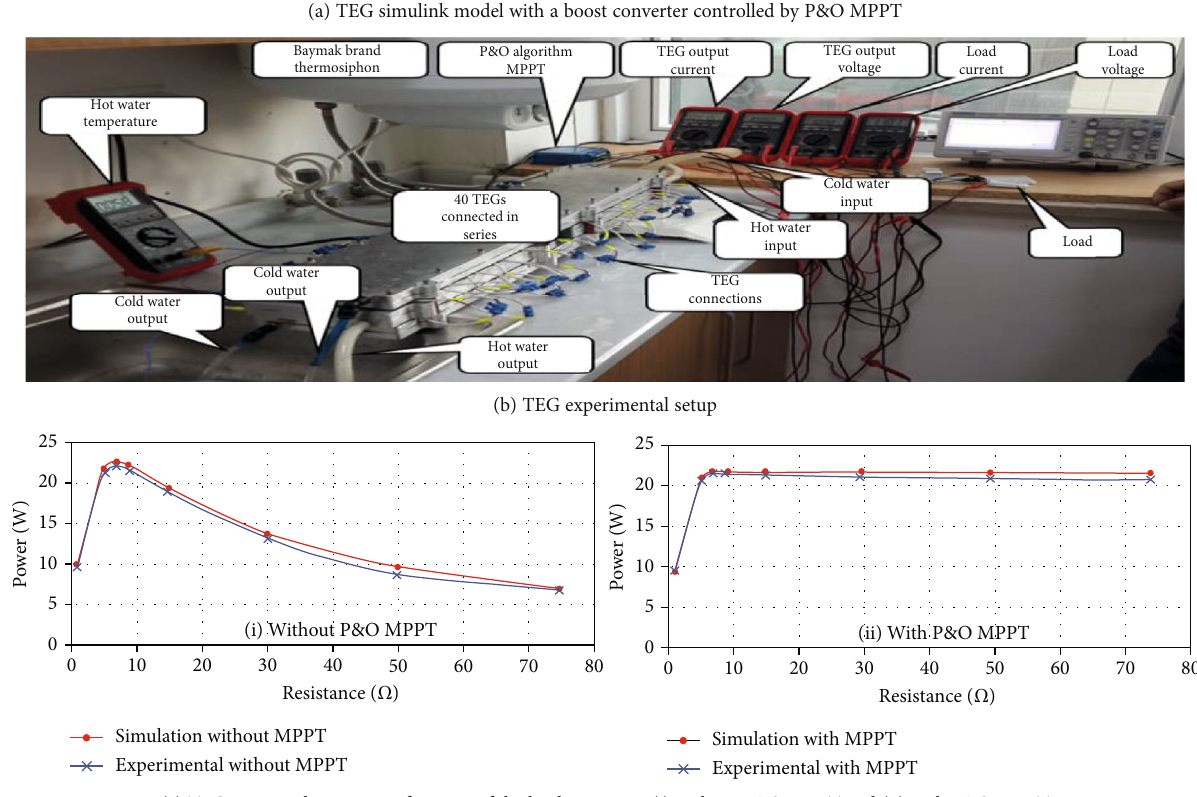
Figure 18: Simulated and experimental TEG, boost converter, and P&O MPPT schemes (adapted from